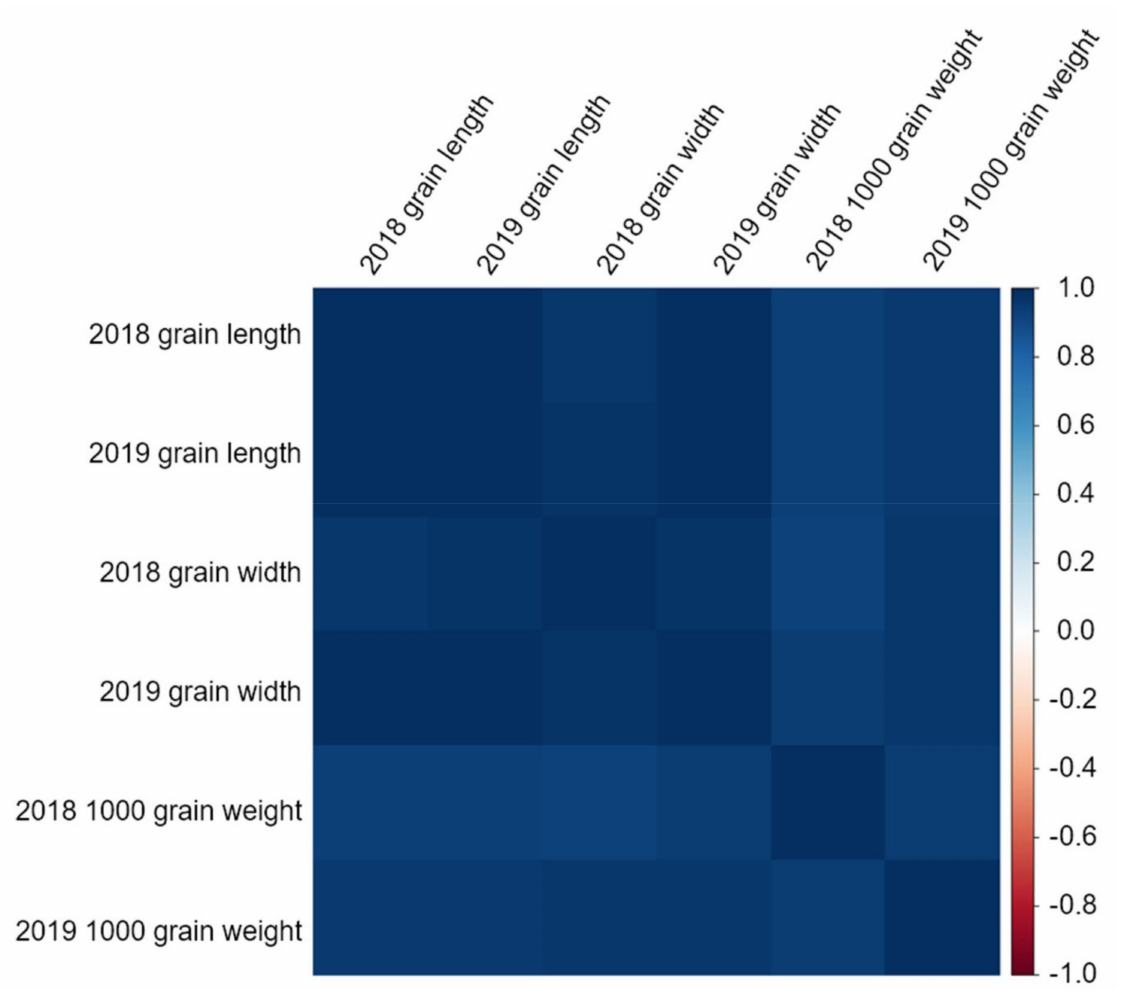
Figure 2. Correlation matrix heatmap with grain characteristics. The grain length, grain width, and 1000 grain weight all showed positive correlations. Therefore, grain shape is an important factor that can increase rice